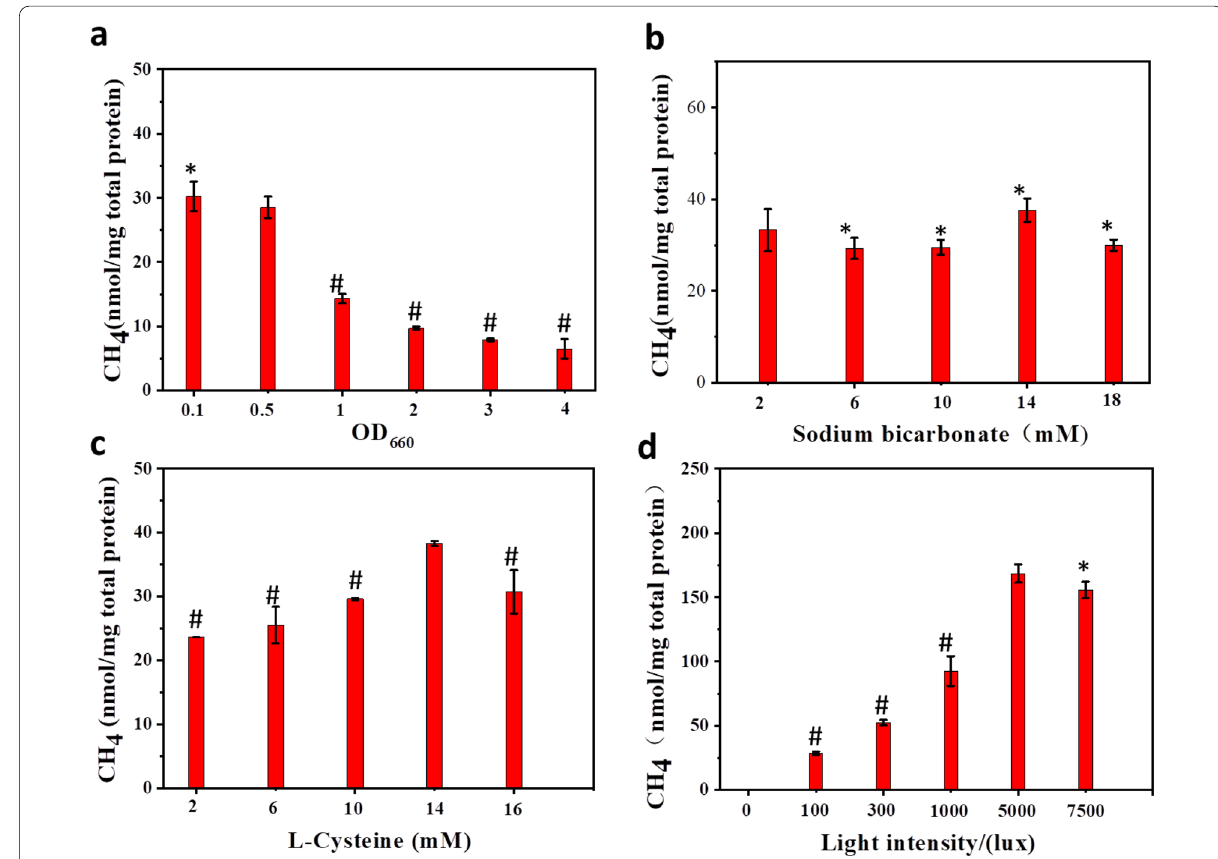
Fig.4 Effect of a cell density, b substrate concentration, c L‑Cys concentration, and d light intensity on the biomethanation performance of RP/ CdS hybrid cells. Apart from the tested parameter, other experimental conditions were the same with those used in Fig. 3. Statistical significance of differences was analyzed by t ‑test, * p > 0.1, # p < 0.01 (marked condition vs. unmarked condition)